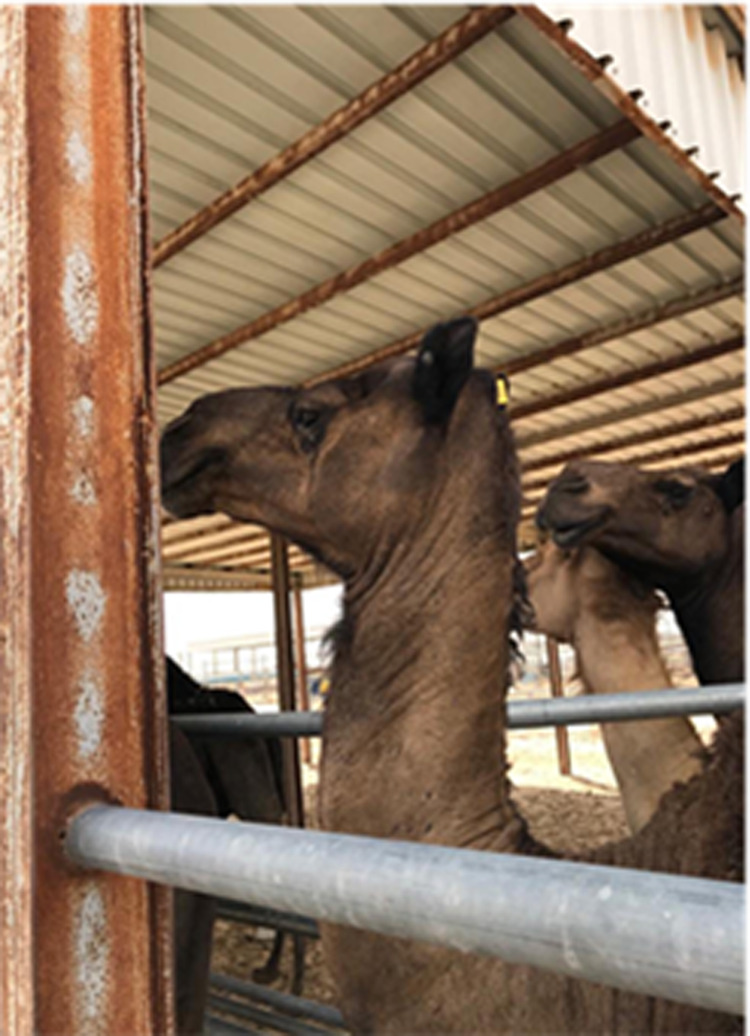
MERS-CoV infection in a Dromedary camels herd. A dromedary camel was showing lacrimation and mild nasal discharge. This animal tested positive by the real-time PCR for MERS-CoV.